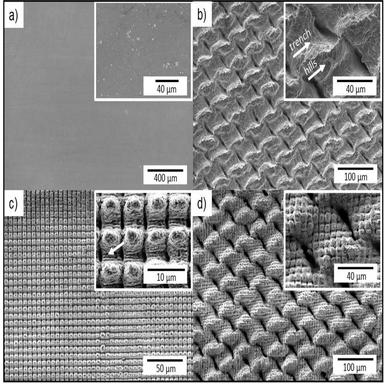
Scanning electron microscope (SEM) images of an untreated Al 2024 reference (a), the mesh-like structure processed with DLW (b), the pillar-like DLIP structures with a spatial period of 7 µm (the arrow in the insert indicates the line-like LIPSS of ~520 nm) (c), and a hierarchical structure resulting of the combination of DLW and DLIP (d).